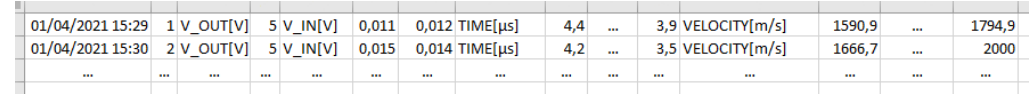
Figure 13. CSV standard file.